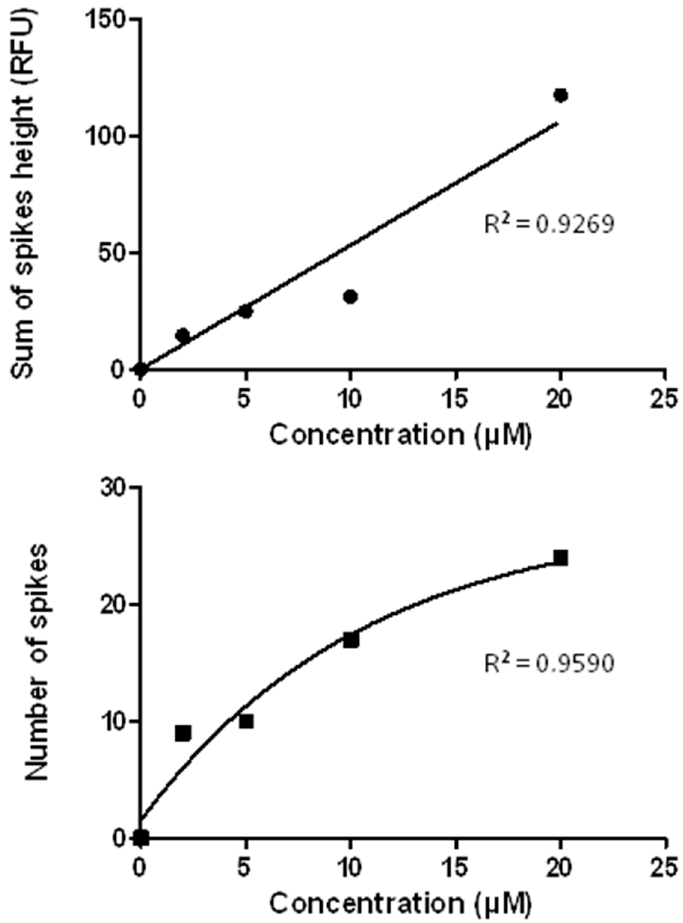
Figure 7. Effect of A β 1-40 concentration during an 18-day incubation on the sum of spikes height ( top ) and on the number of spikes ( bottom ) obtained during the CE-LIF separation performed after hydrodynamic injection (2 psi/80 s). Running buffer as in Figure 1. Curve fitting: top: linear regression; bottom: non-linear fitting, one phase association.